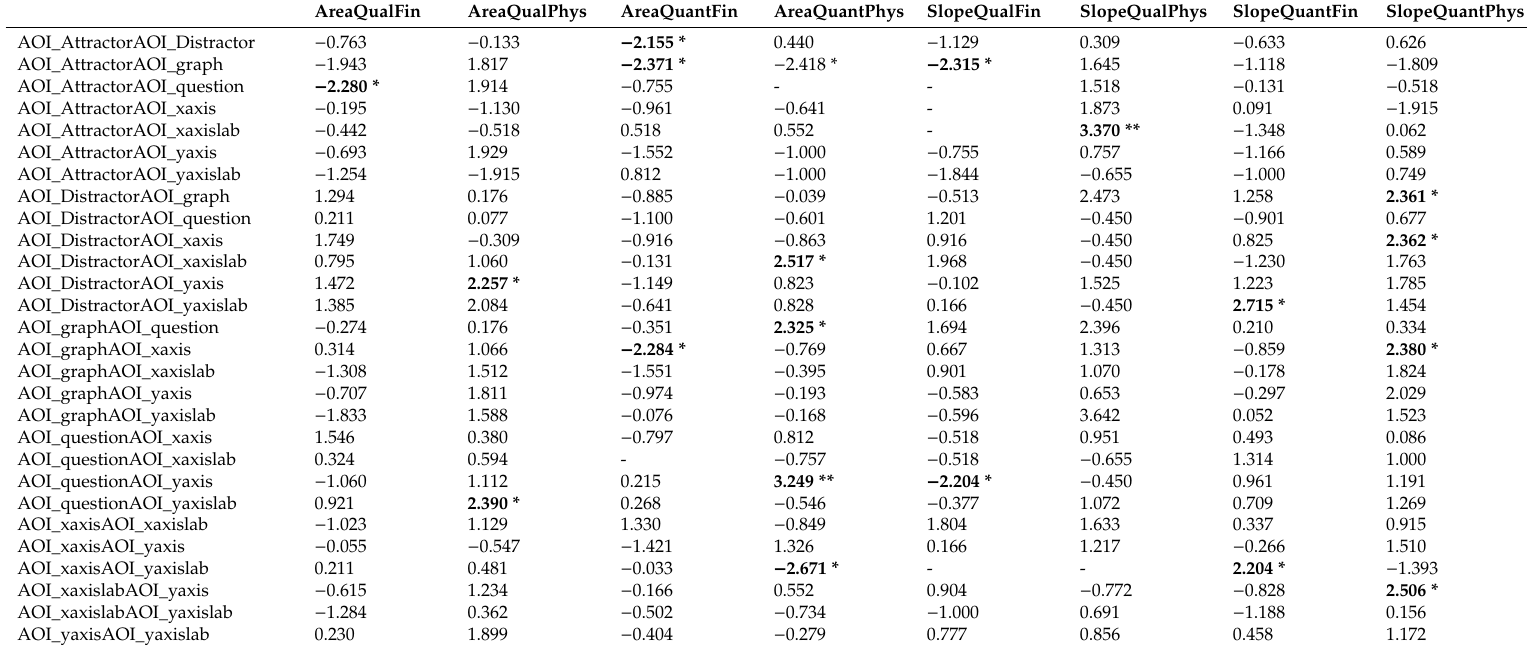
Table 5. T -test results showing the di ff erences in transition frequencies between correct and incorrect solvers per task for each of the 28 transition types. Negative values indicate di ff erences that favor correct solvers (Bold = significant result, * p < 0.05, ** p <